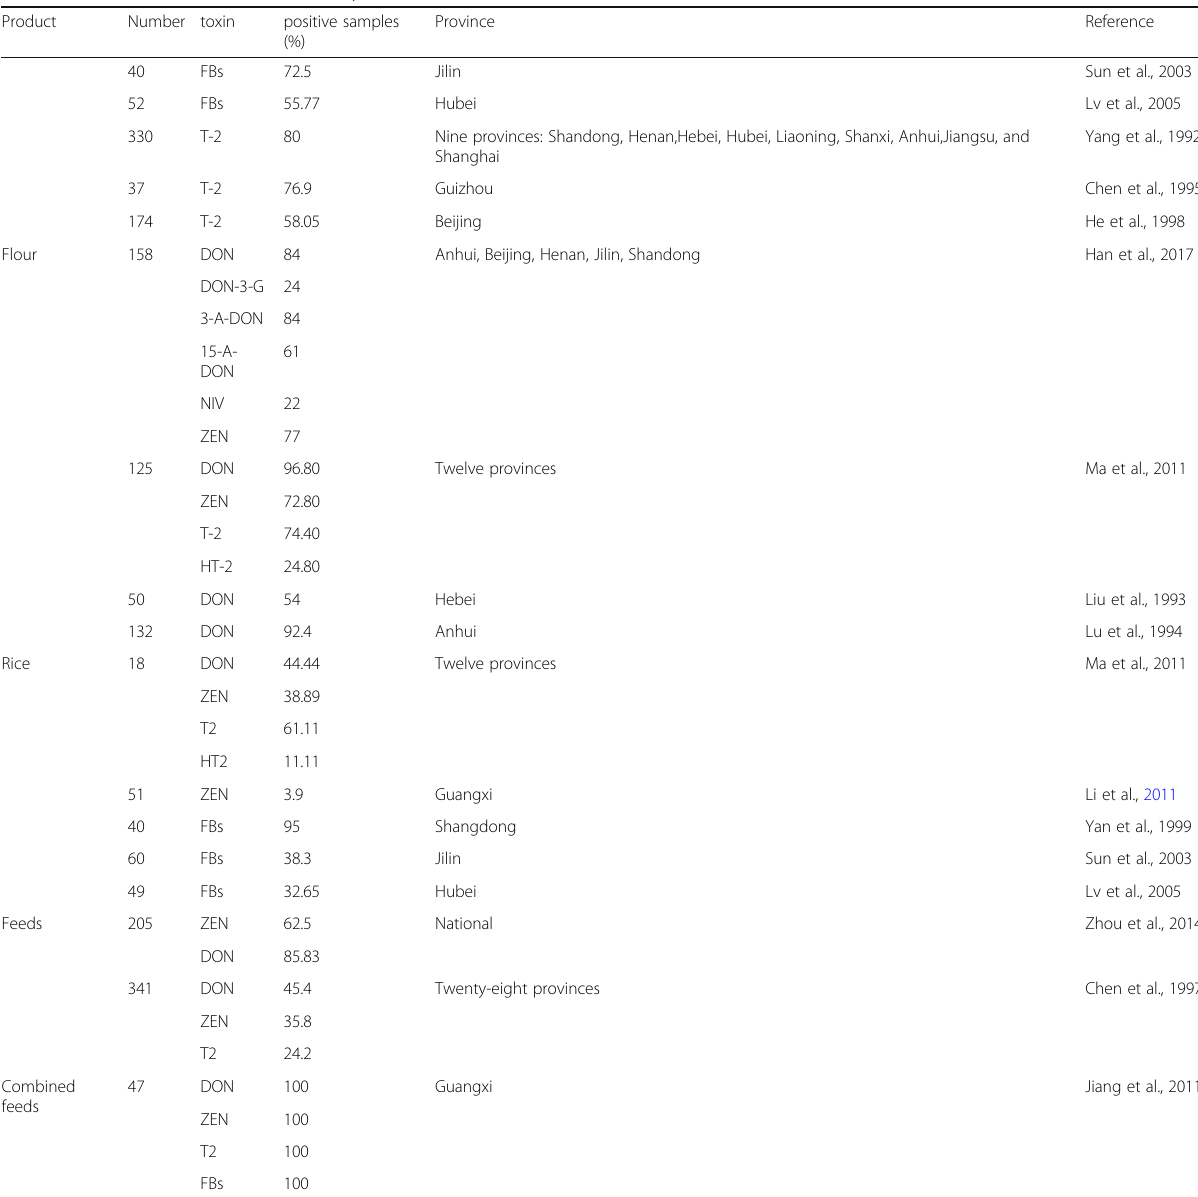
Table 4 Contamination of Fusarium mycotoxins in foods and feeds in China (Continued) Product Number